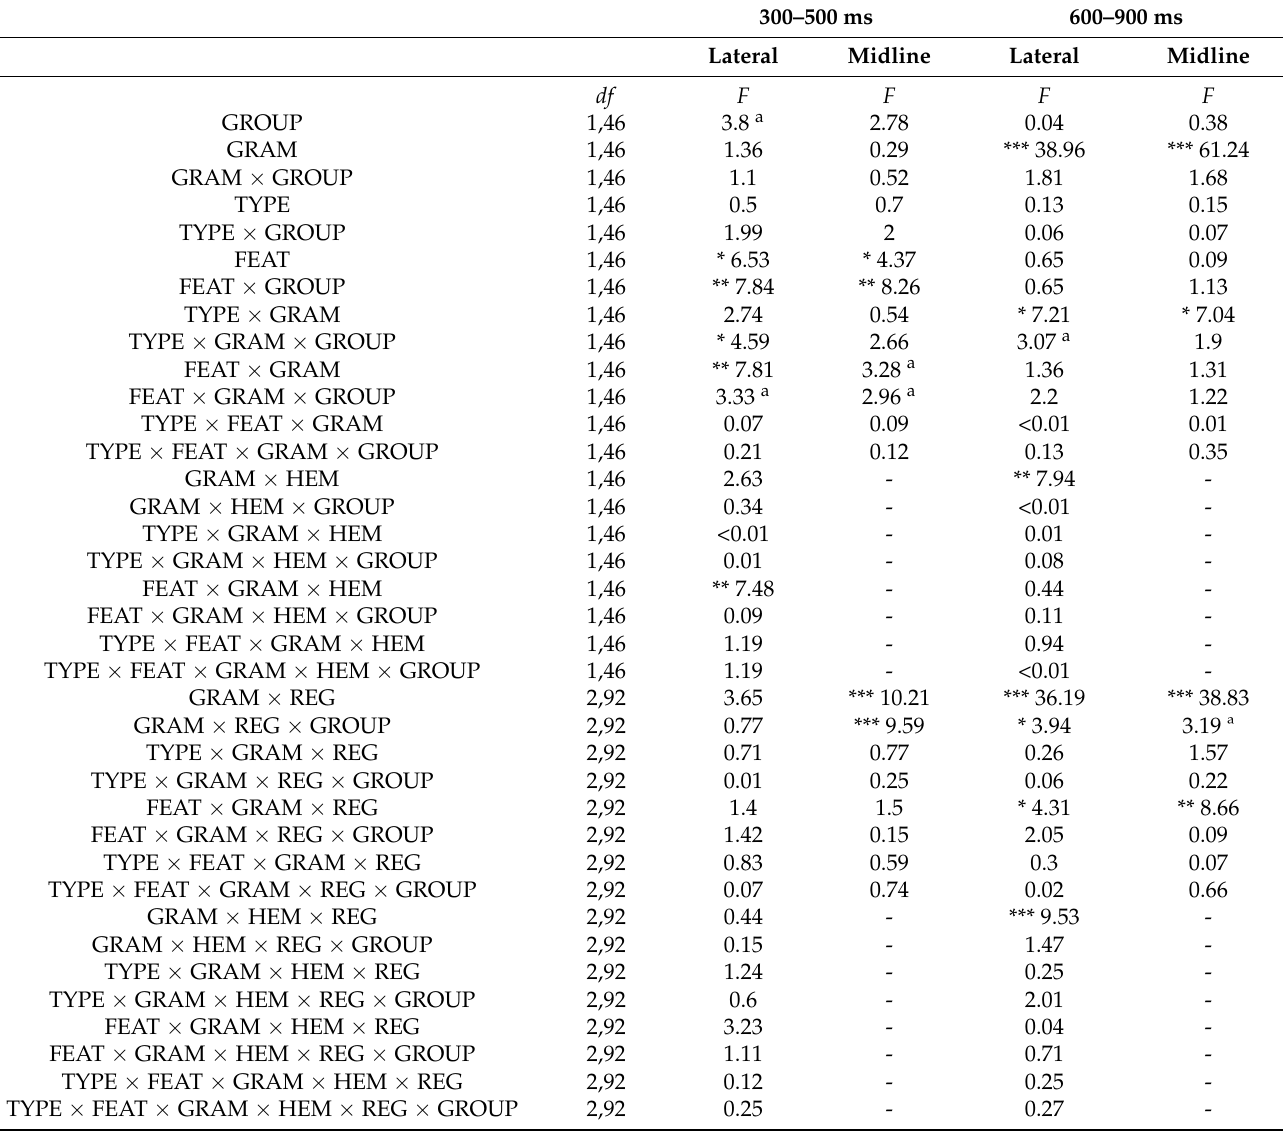
Table 5. Statistical results (EEG data) Notes: GRAM: grammaticality (two levels); TYPE: predicate type (two levels); FEAT: feature type (two levels); HEM: Hemisphere (two levels); REG: Anterior- Posterior factor (3 levels); df: degrees of freedom. a p < 0.1, * p < 0.05, ** p < 0.01, *** p <